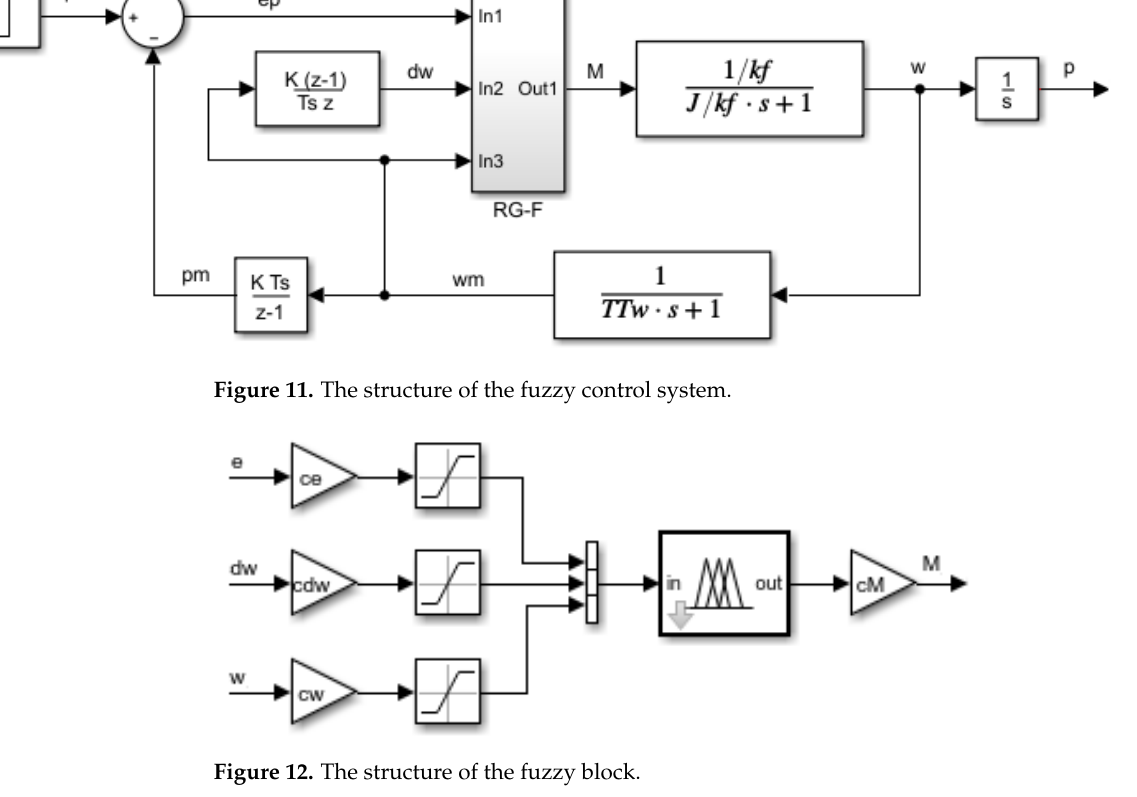
Figure 12. The structure of the fuzzy block.